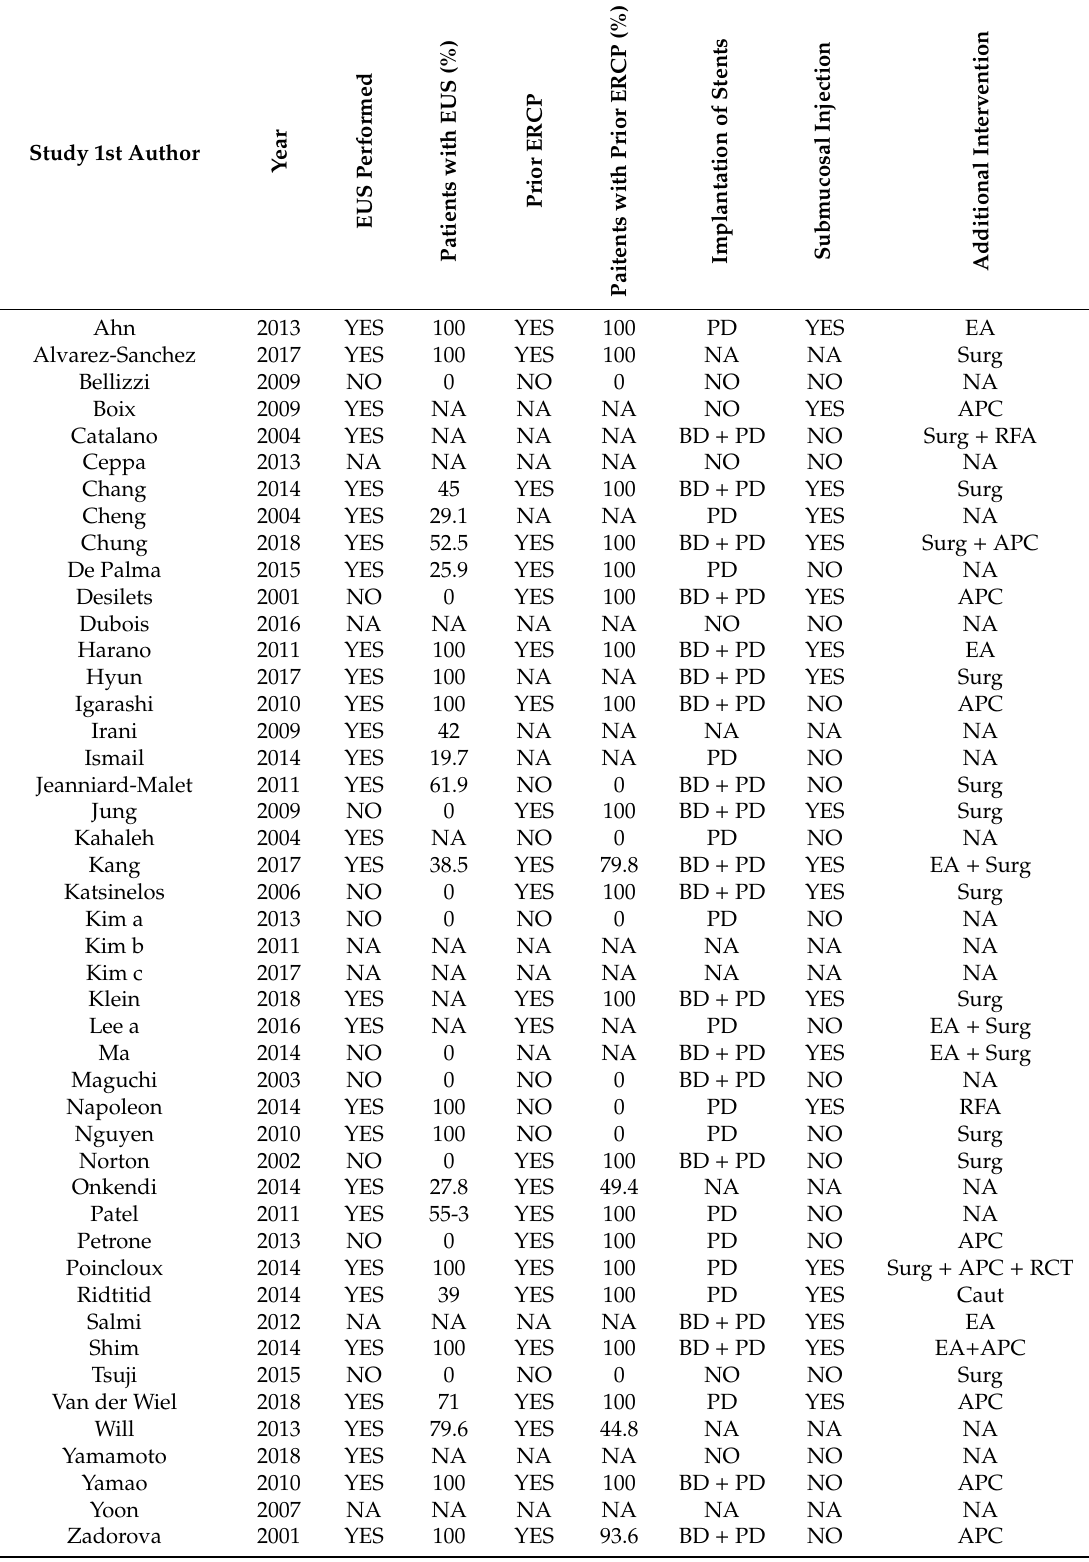
Table 4. Technical specifications of endoscopic